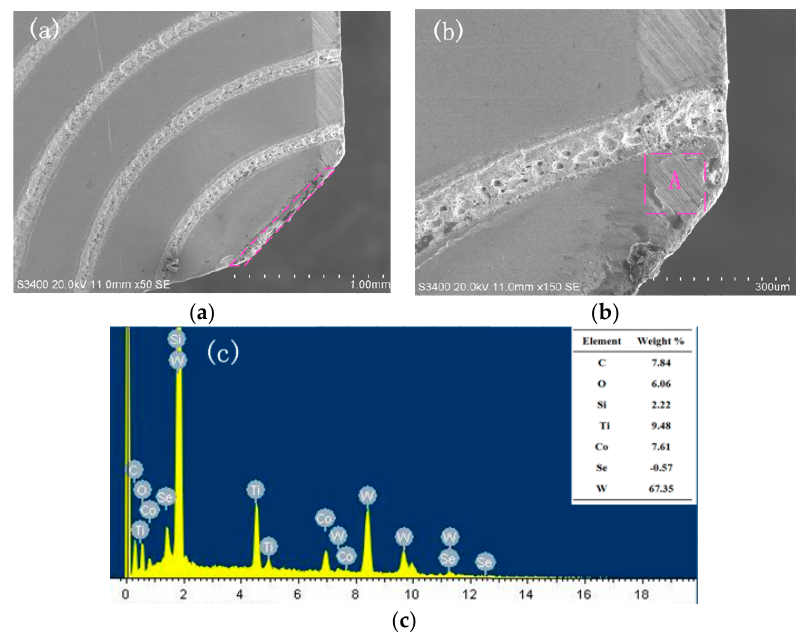
Figure 8. SEM and EDX of wear at the rake face of sinusoidal textured tool ( v = 90.4 m/min, a p = 0.4 mm). ( a ) Wear morphology; ( b ) Enlarged morphology; ( c ) EDX of zone A.